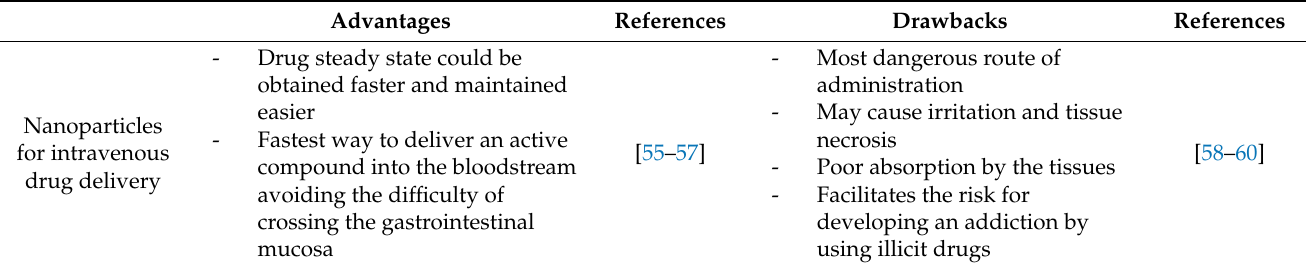
Table 2. Classification of nanoparticles by routes of